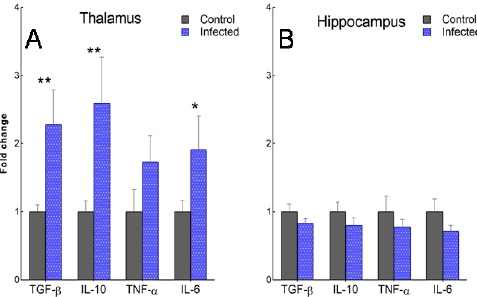
Figure 7. Gene expression of the anti-inflammatory cytokines TGF- β and IL-10 , and the proinflammatory cytokines TNF- α and IL-6, in the thalamus ( A ) and hippocampus ( B ) of control and naturally scrapie-infected sheep. Data are represented as the mean ± SEM fold change with respect to controls (expressed as a score of 1). Mean scores were compared using the Student’s t-test or Mann–Whitney U test for normally and non-normally distributed data, respectively. * p < 0.05 , ** p < 0.01.